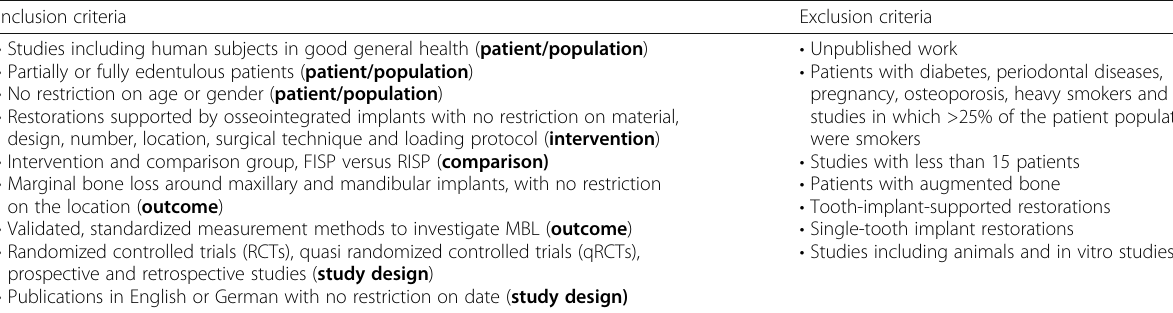
Table 3 Eligibility criteria Inclusion criteria Exclusion